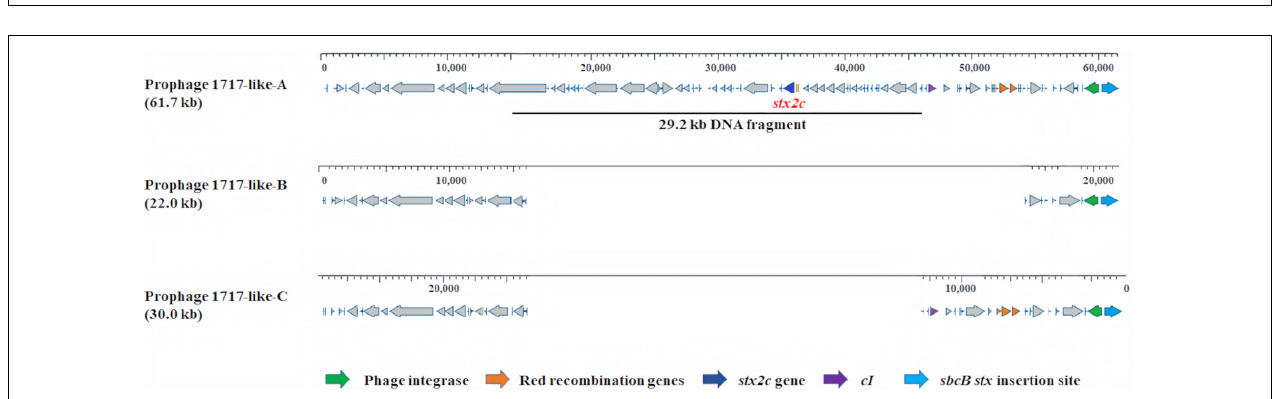
FIGURE 2 | Prophage comparison at yehV stx insertion sites in Escherichia coli O157:H7 strains used in this analysis. The stx1 -carrying prophage Sp15 was present in strains Sakai and C1-067 ( stx1 +, stx2a +). The stx -negative prophage Sp15-like was present in seven stx -negative strains and strain C1-010 ( stx1 +, stx2- ). A 12.8 kb DNA fragment of the stx1 -carrying prophage Sp15 containing the genes stx1A and stx1B (fragment 1) and a 10.2 kb DNA fragment that does not contain the stx genes of the stx -negative prophage Sp15-like (Fragment 2) are presented.